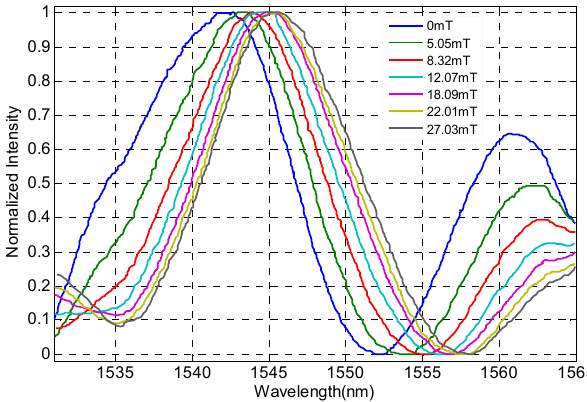
Figure 5. Spectrograms under a magnetic field range of 0~30 mT.